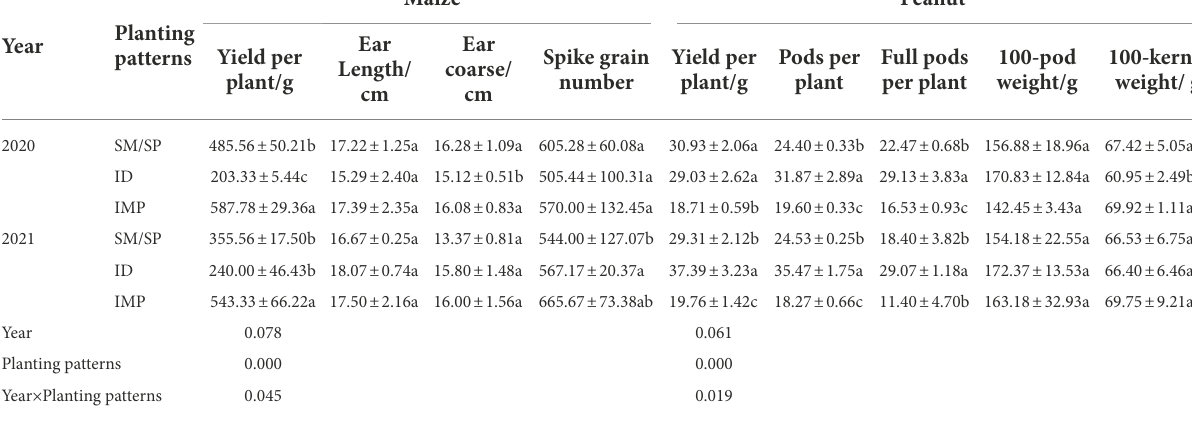
Different lowercase letters represent significant difference level p = 0.05 using Duncan’s test, as follows. SM: sole maize, SP: sole peanut, ID: intercropping of maize and peanut with board separation, IDM: intercropped maize with board separation, IDP: intercropped peanut with board separation, IMP: intercropping of maize and peanut, IM: intercropped maize, IP: intercropped